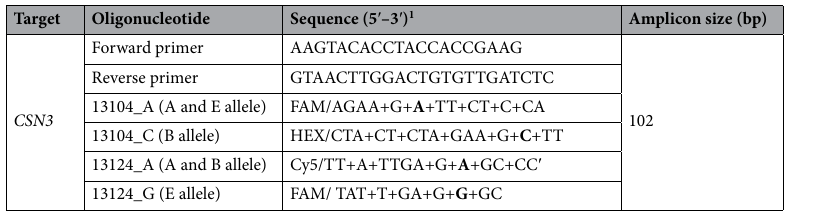
Ƙ -Casein genotype Position Reporter AA AB AE BB BE EE